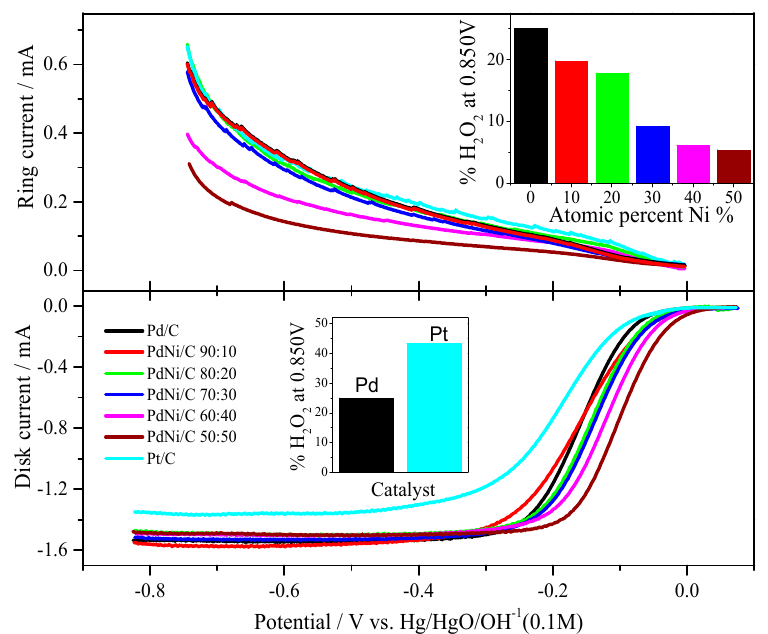
Figure 6. ORR polarization curves of Pt/C, Pd/C and PdNi/C in 0.1 M NaOH solution saturated with oxygen, and ring current corresponding to H 2 O 2 . Rotation rate: 2500 rpm. Sweep rate: 0.005 V s − 1 . (Inset: Production of %H 2 O 2 by Pd/C and PdNi/C, and comparison of Pd/C with Pt/C).